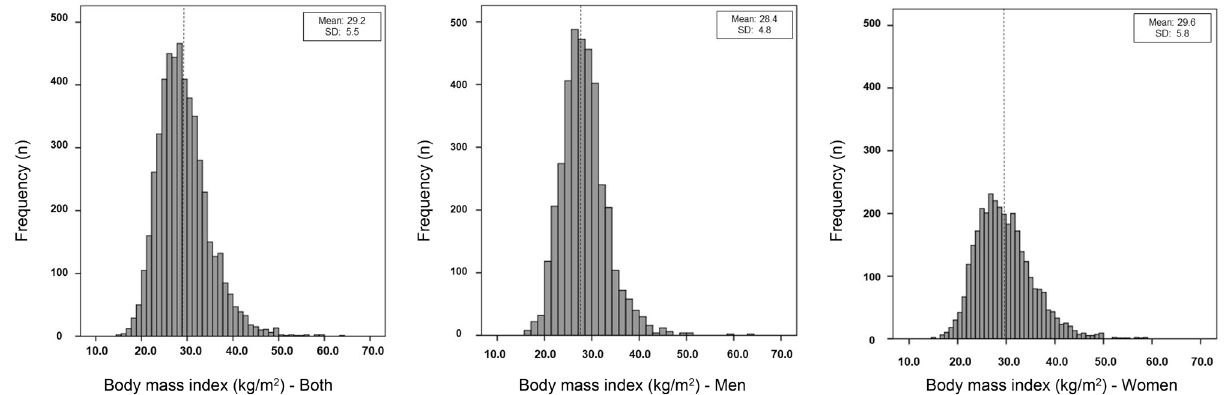
Figure 1. Distribution of body mass index (kg/m 2 ) in adults from Chile by sex, 2016–2017.